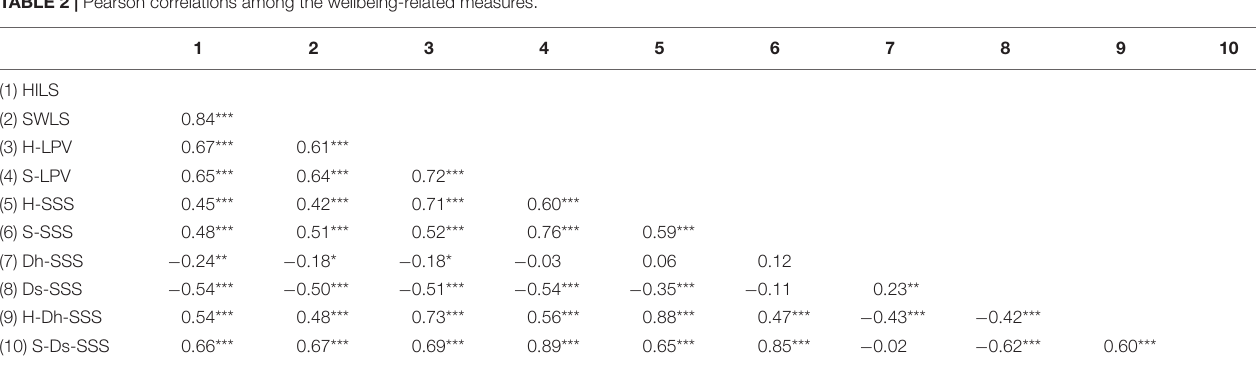
TABLE 2 | Pearson correlations among the wellbeing-related measures.